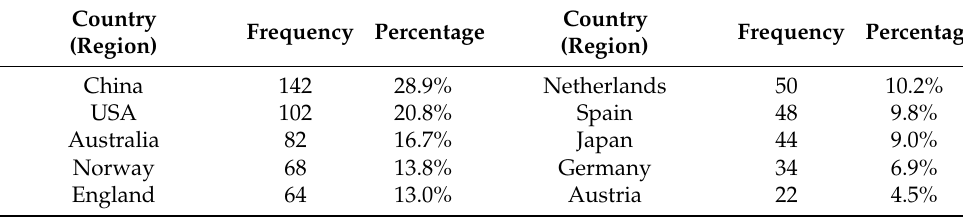
Table 2. Top 10 countries (regions) based on frequency.